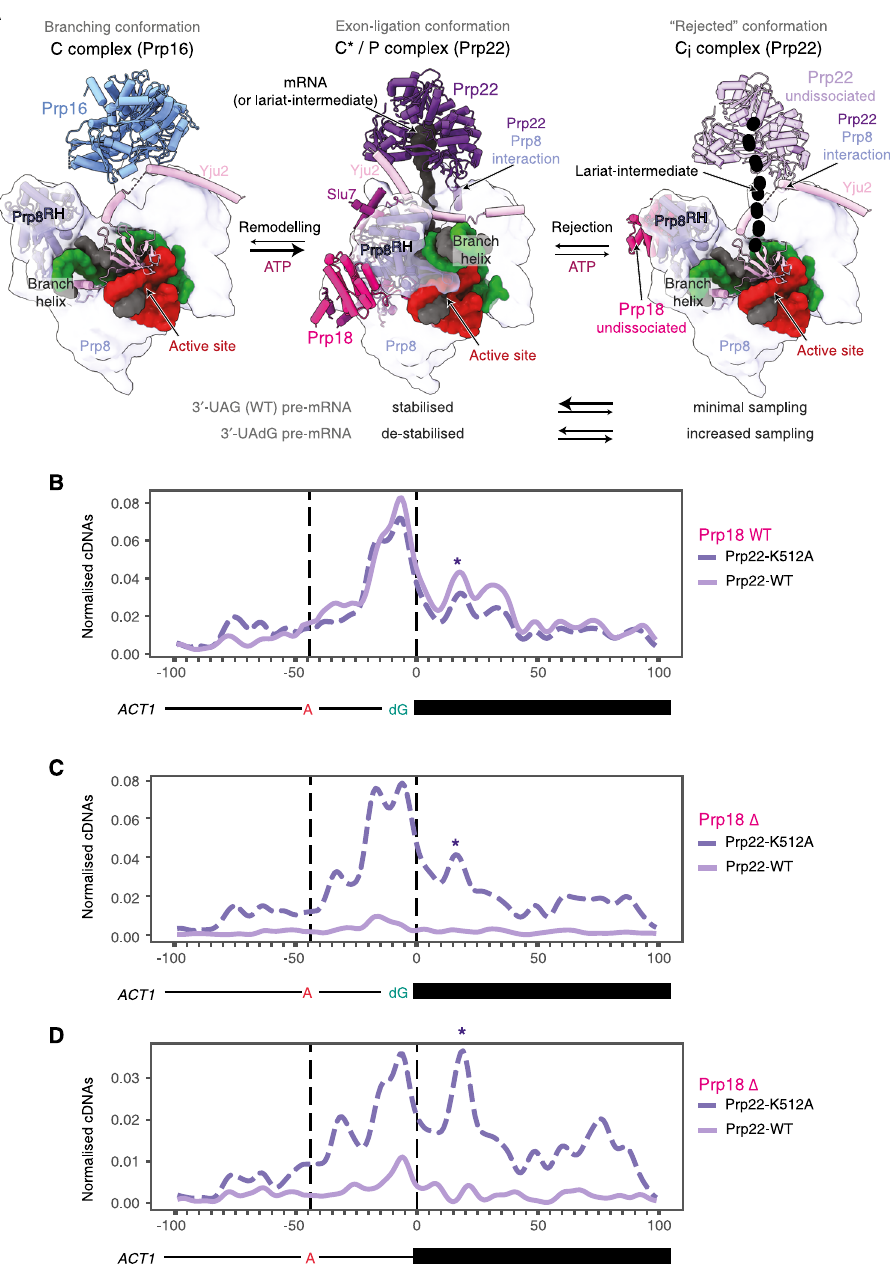
Fig. 6 Prp18 depletion destabilizes wild-type Prp22 binding on the pre-mRNA substrate, but not the binding of the ATPase-de fi cient Prp22 mutant. A Binding of Prp22 in the exon-ligation conformation in C* (ref. 10 ; PDB: 5MQ0 and P (ref. 12 ; PDB: 6EXN) complexes is stabilized by Prp18 and Slu7 (middle panel). For comparison, binding of Prp16 is shown in the C complex (left panel). During rejection by Prp22, the spliceosome may revert to a C-like conformation (C i , ref. 43 ; PDB: 7B9V), in which both Prp18 and Prp22 may remain loosely bound (right panel). B Prp22 binding to spliceosomes assembled on the suboptimal 3 ′ -UAdG substrate in mock-depleted extracts. C psiCLIP of Prp22 in spliceosomes assembled on the 3 ′ -UAdG substrate following depletion of Prp18 (Prp18 Δ ). D psiCLIP of Prp22 in spliceosomes assembled on the wild-type ACT1 substrate following depletion of Prp18. Both wild-type and ATPase mutant Prp22 are shown for all experiments. The proposed P-complex-like signal, potentially diagnostic of 3 ′ -SS docking, is indicated with an asterisk (*). In all panels, crosslinks are shown normalized to endogenous yeast RNA, with reads from untagged Prp22 subtracted from tagged Prp22 reads, and after applying Gaussian smoothing with a ten nucleotide